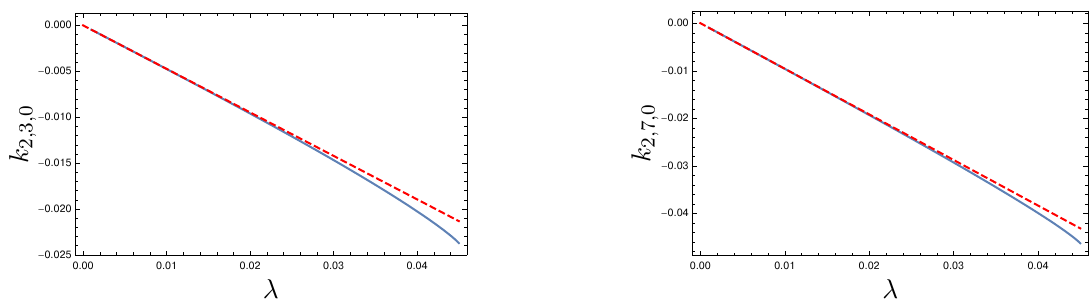
b vacua constructed from the ‘seed’ (5.40). The A V